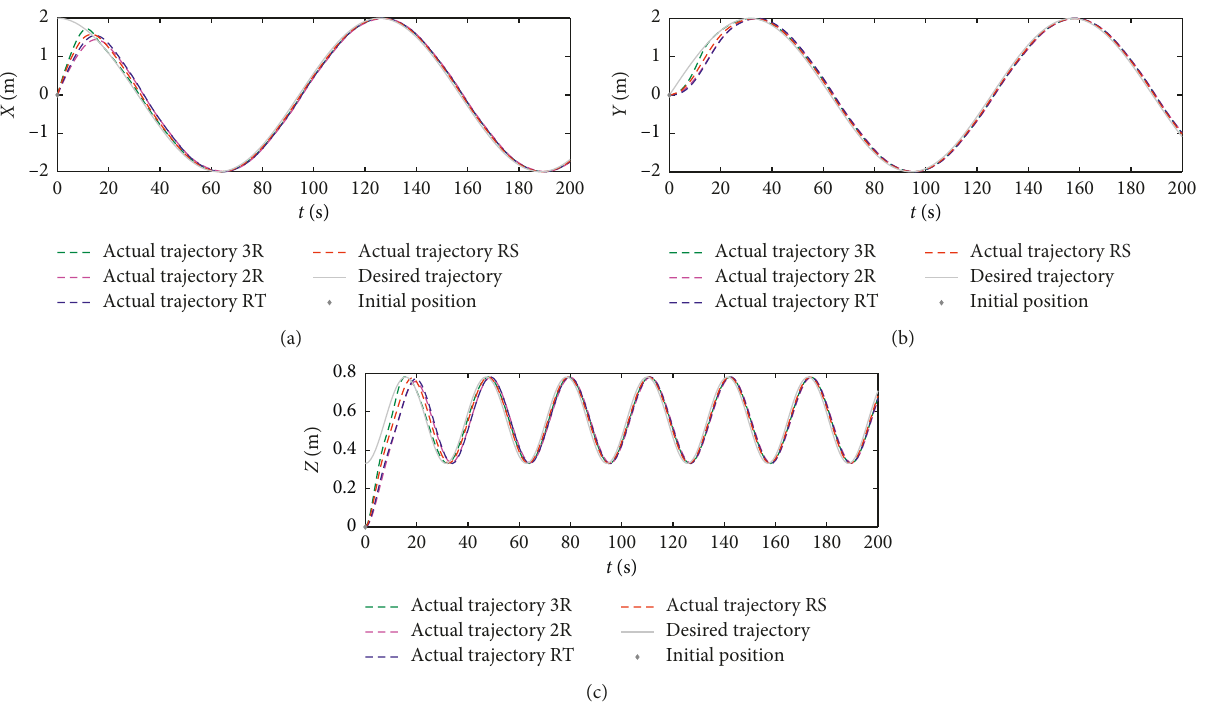
Figure 8: Robots’ actual and desired smooth trajectories along X , Y , and Z directions versus time.